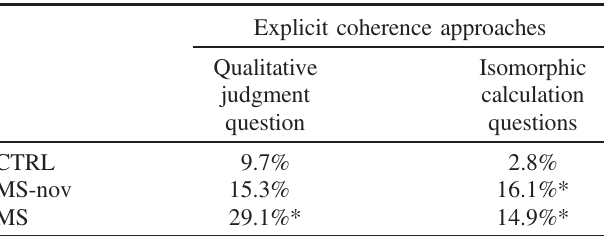
TABLE V. The percentage of explicit coherence-seeking ap- proaches (both calculation and conceptual reasoning) used on the qualitative judgment question and the percentage of students who gave at least one explicit coherence-seeking solution on the isomorphic calculation questions. * indicates percentage is greater than CTRL percentage, p < 0 . 01